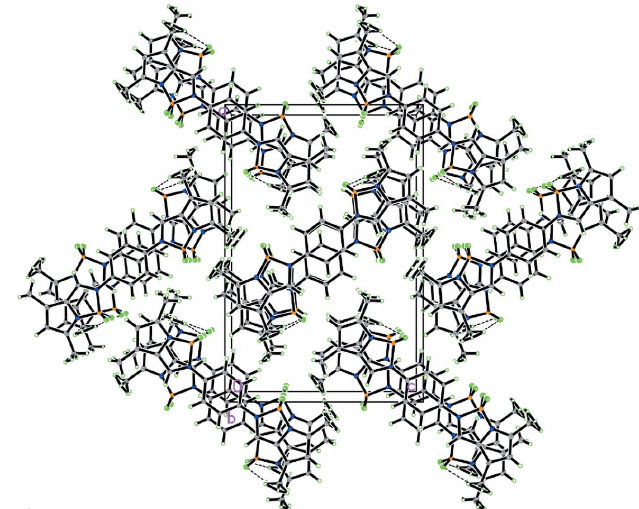
Figure 3 Part of the packing diagram for the title compound.